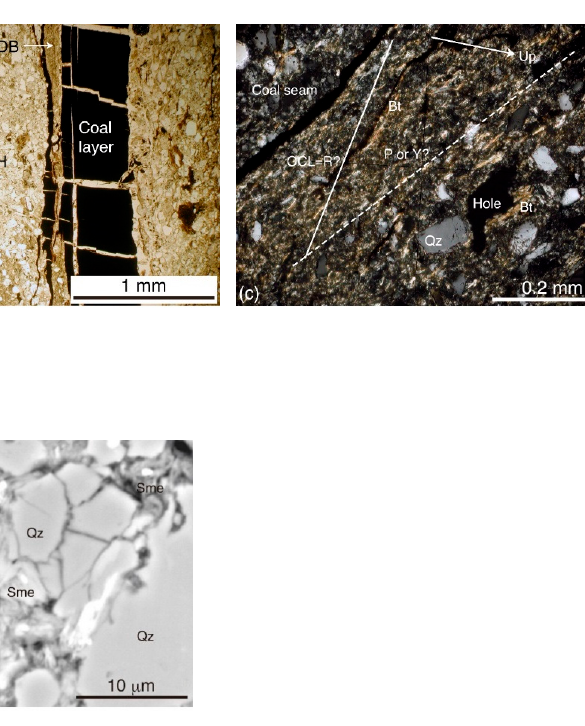
Figure 5. Microphotographs of deformation bands in borehole core sample B6. ( a ) Whole thin section (plane polarized light), where deformation bands and host areas are divided by red dashed lines. See Figure 3c for the locality. ( b ) Microstructures of coal seams, deformation bands (DB) and host areas (H) (plane-polarized light). ( c ) Alignment of fine-grained biotite grains in deformation bands shown by white dashed lines (crossed polarized light). OCL, orientation of coal layer in ( a ). ( d ) Extended and kinked biotite grains (crossed polarized light, shown by a white arrow). ( e ) Authigenic smectite grains grown in pore spaces created by fracturing of detrital grains. Measurements points for microchemical analysis with EPMA are indicated by filled red circles. See Table 3 for the compositions. See ( a ) for the localities of ( b – e ). The up direction of the borehole is shown by arrows in the diagrams ( a – d ). Qz, quartz; Pl, plagioclase; Bt, biotite; Sme, smectite.